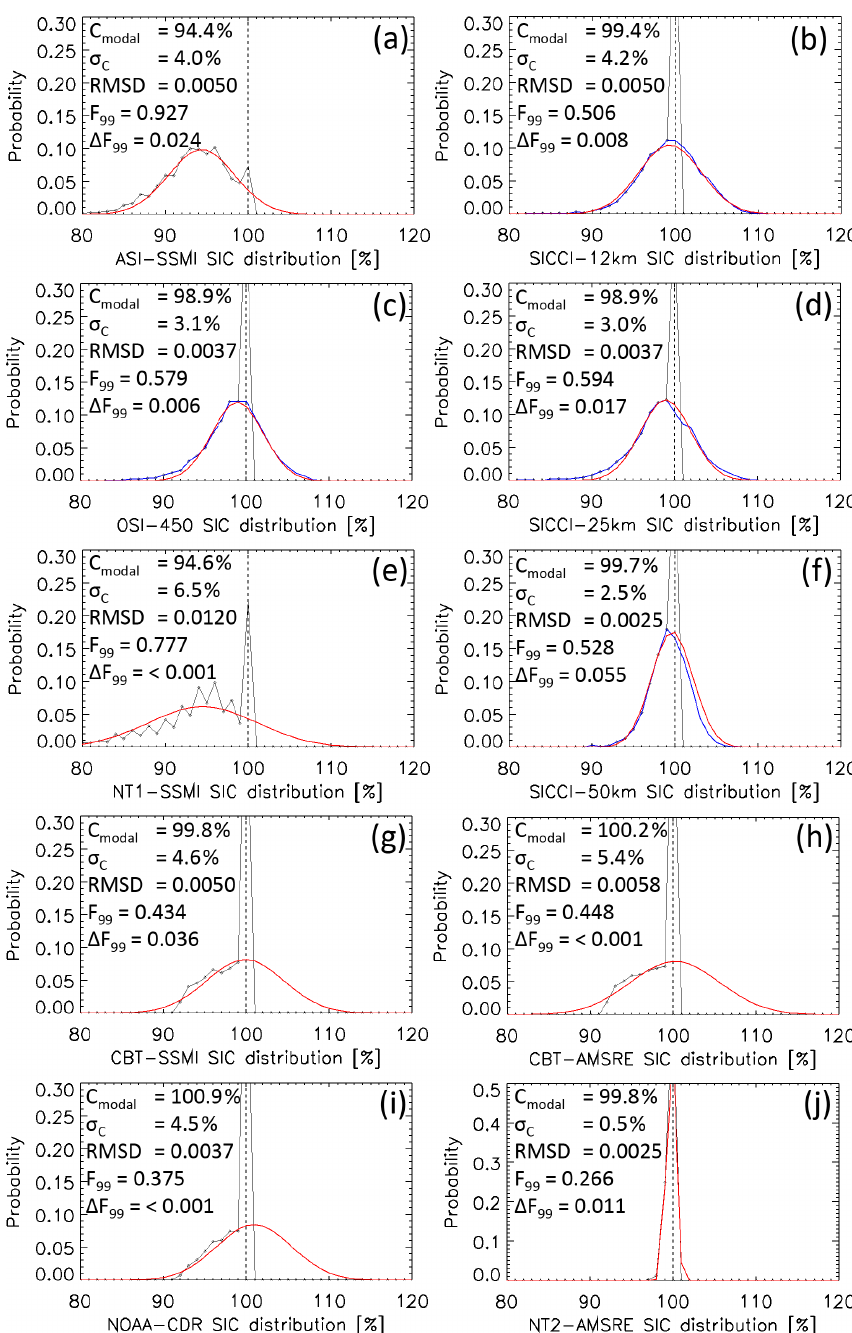
Figure H2. As Fig. H1 but for the Antarctic.